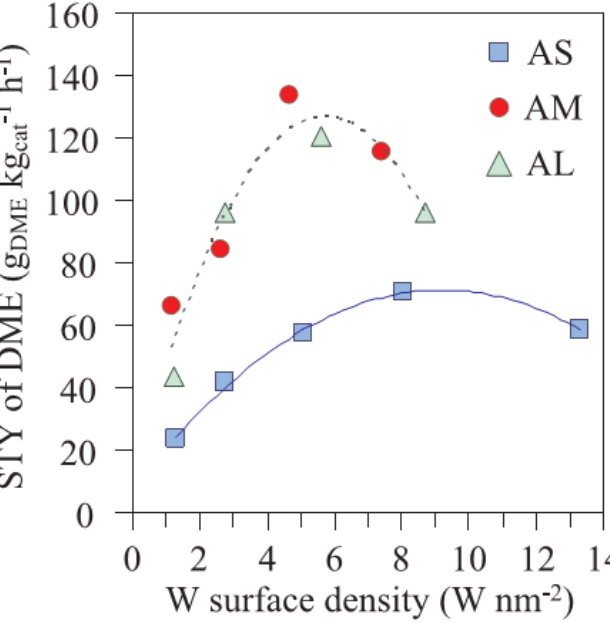
Figure 13. STY of DME of different WO x /Al 2 O 3 catalysts, with different support pore size as a function of W surface density. AS, AM, and AL refer to the mean pore size of alumina supports with small, medium and large pores, respectively, reproduced with permission from [83]. Copyright Elsevier, 2018.